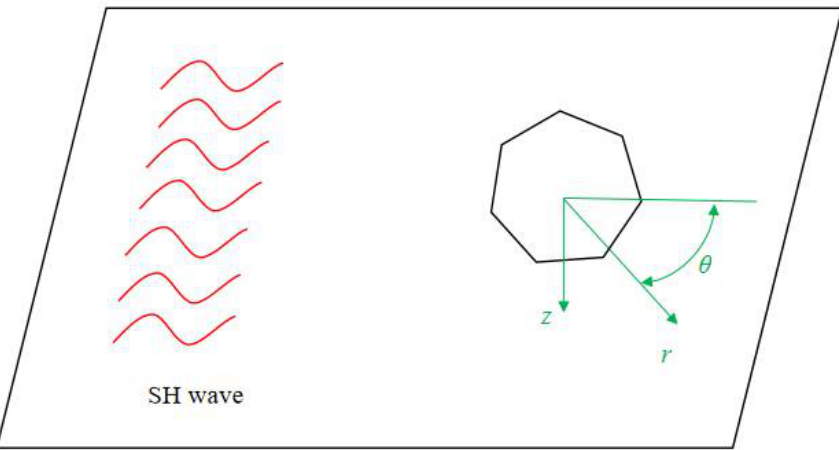
Figure 1. Schematic diagram of the setting of the coordinate system and the incidence of SH waves. For the two-dimensional anti-plane problem, the out-of-plane displacement and in-plane electric field are only functions of coordinates r and θ , and all physical quantities depend only on the anti-plane displacement w and in-plane electric potential ϕ .